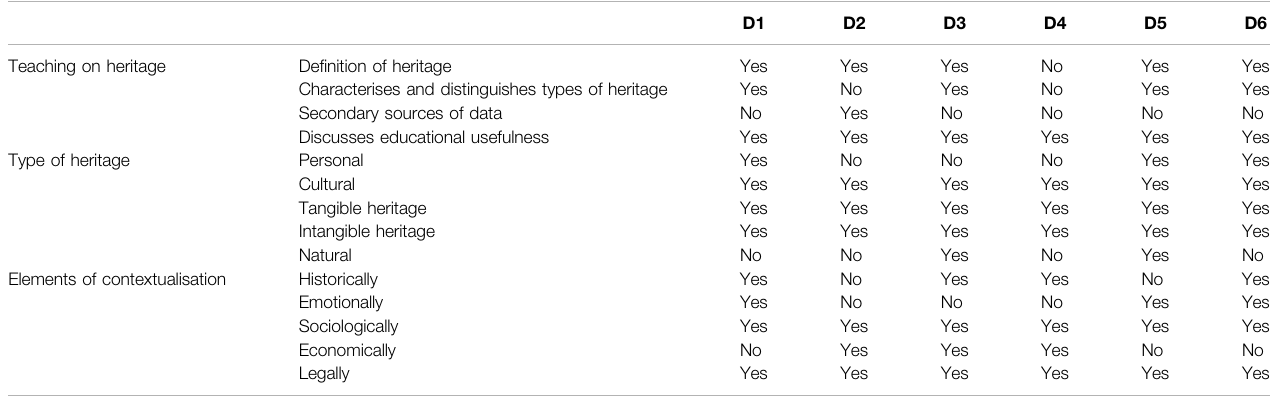
TABLE 6 | Comparison of the written assignments on the Way of St.